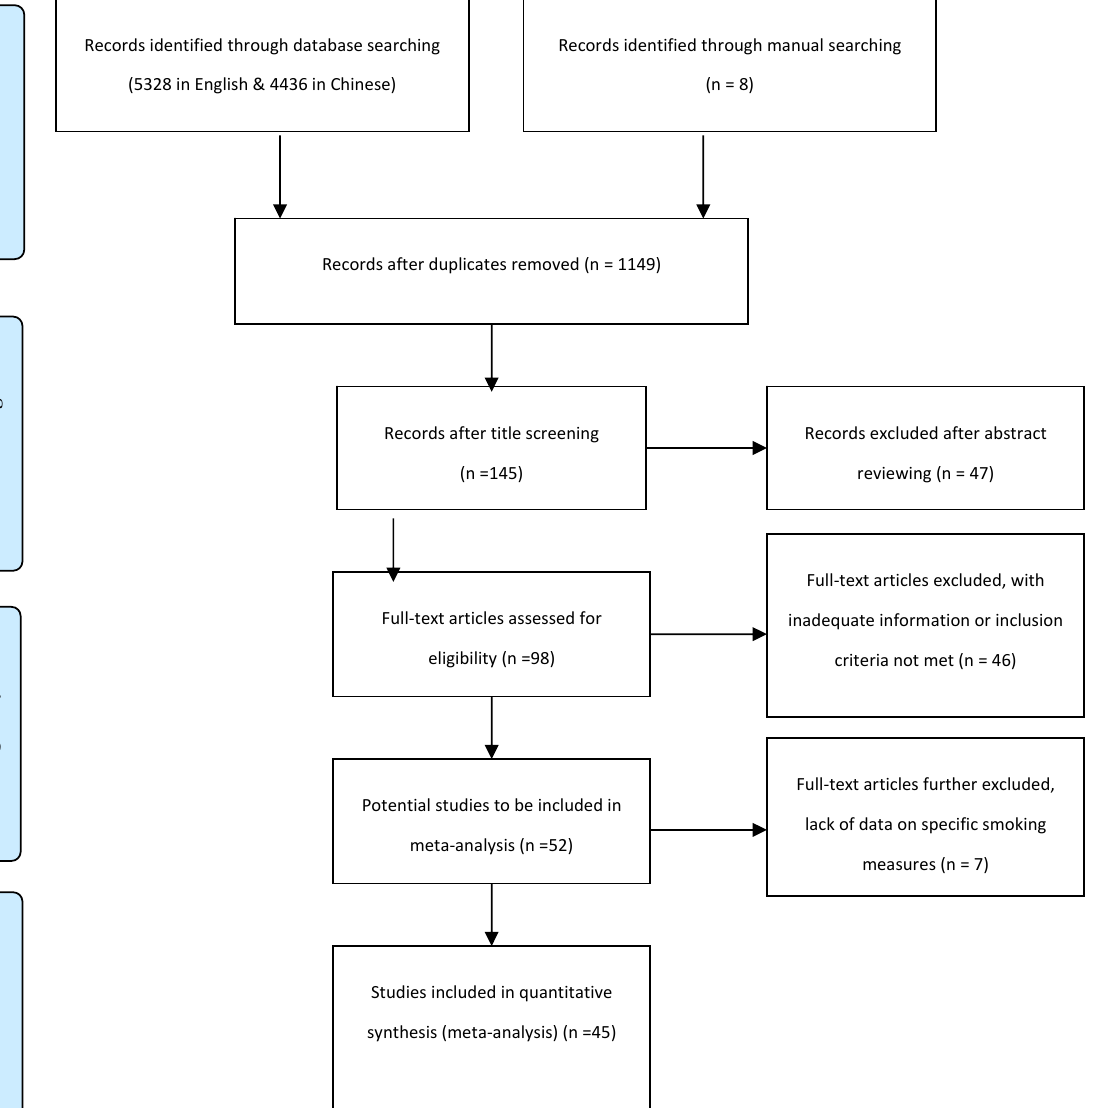
Figure 1 . Flow diagram of paper selection for the